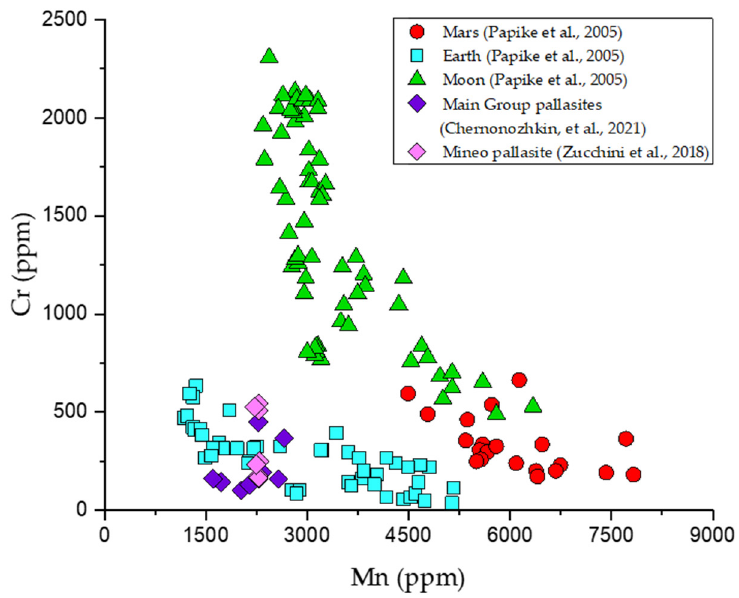
Figure 6. Concentration of Cr (ppm) and Mn (ppm) in olivine from planetary basalts, compared with the concentration found within 8 PMG olivines [57] and Mineo pallasite olivines [41]. Modified after Papike et al. (2005) [58].